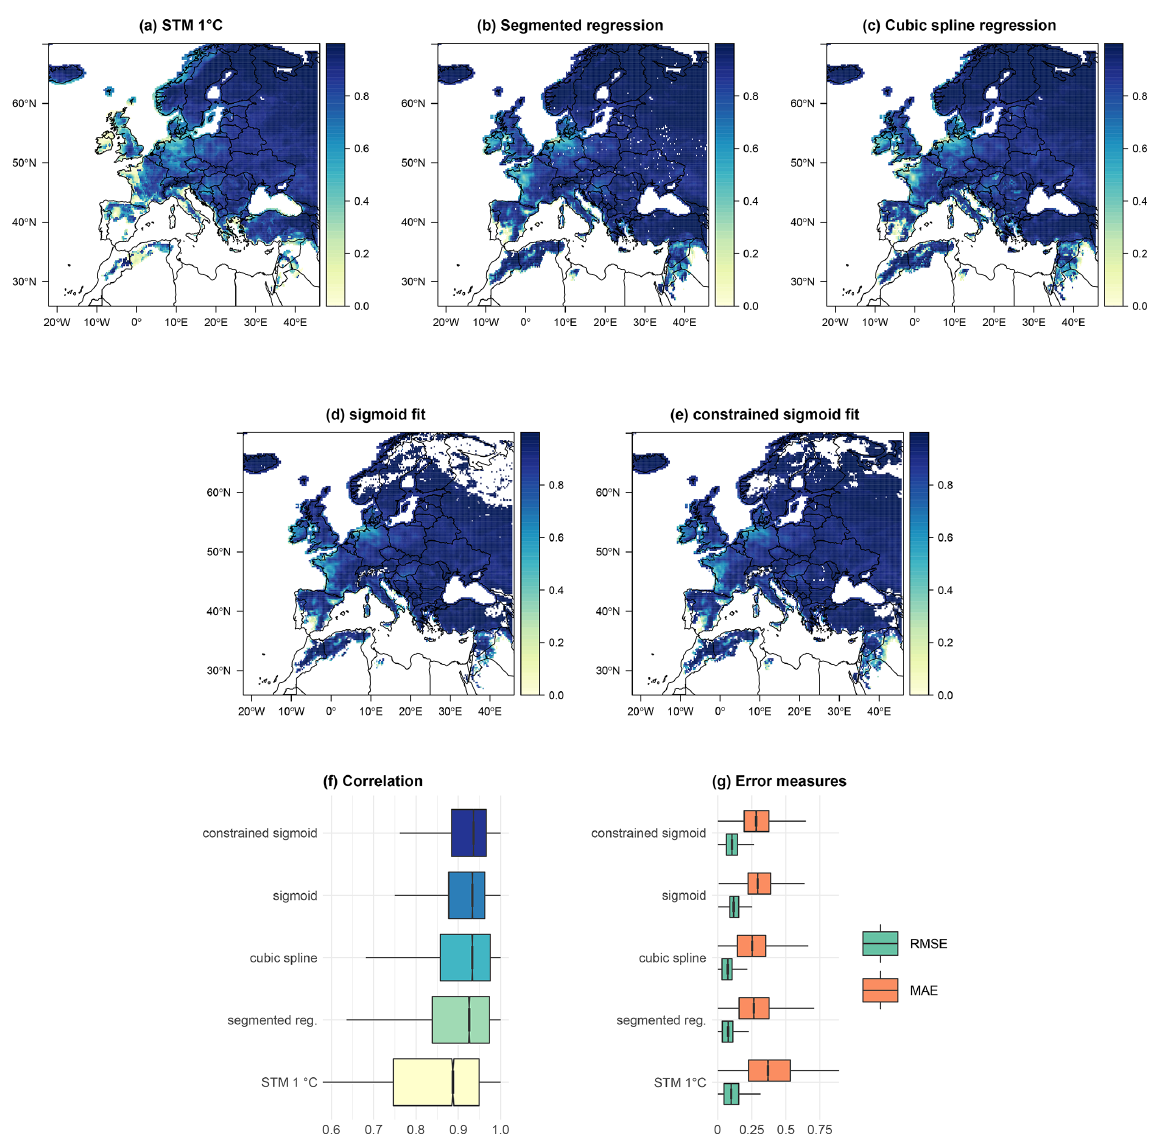
Figure 7. Performance of the statistical methods for the prediction of snow fraction, trained on the 25% coldest ERA5 years, in forecasting in the 25% warmest years. (a–e) Maps of Pearson’s correlation coefficient between prediction and reanalysis. (f, g) Comparison of the box plots of the correlation coefficient and of the statistical method performance in terms of RMSE and MAE, respectively. White points over northern Europe and Russia indicate non-convergence of the two sigmoid